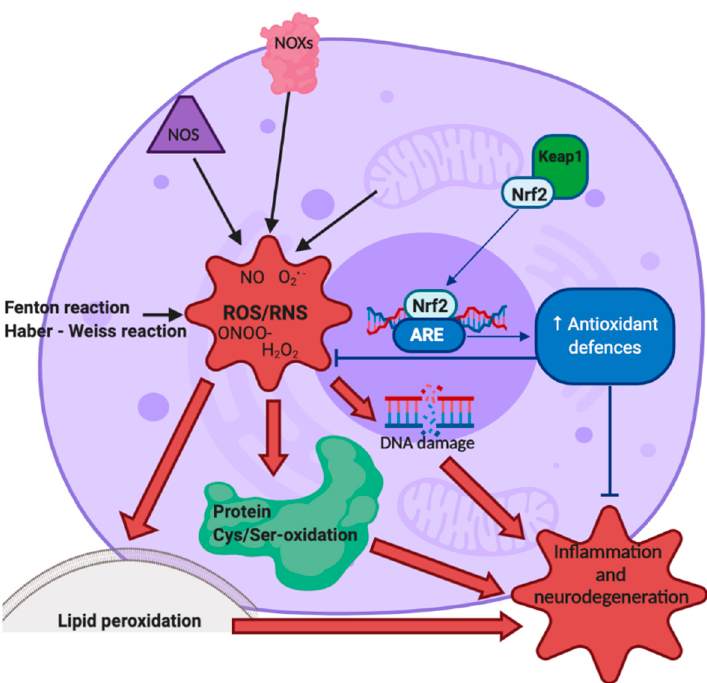
Figure 1. Schematic representation of oxidative stress sources and effects. Image created with BioRender.com.